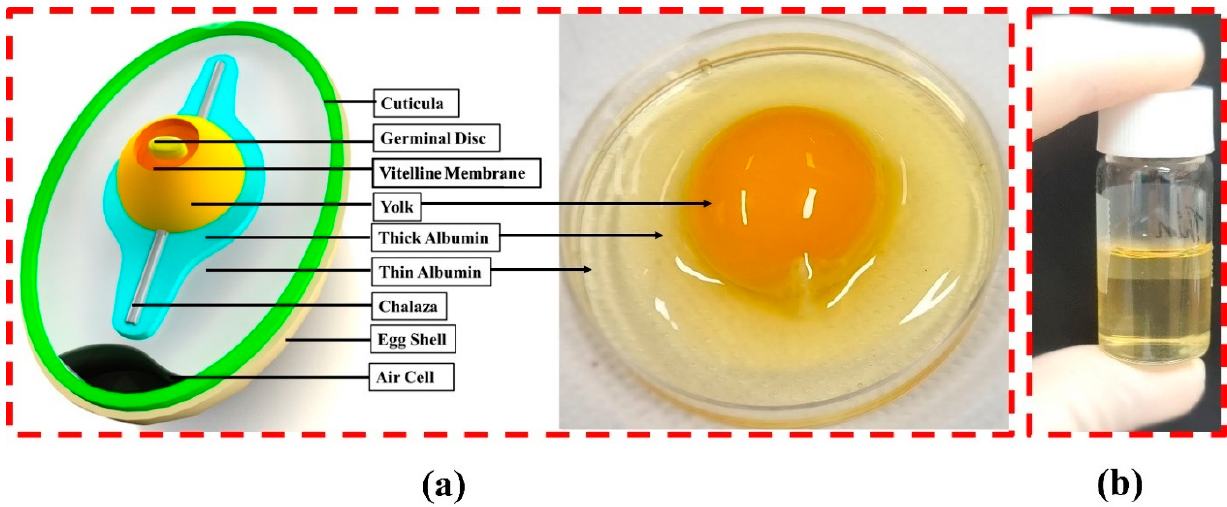
Figure 1. ( a ) Schematic diagram of an egg with image of a chicken egg; ( b ) image of egg white dissolved in deionized water.